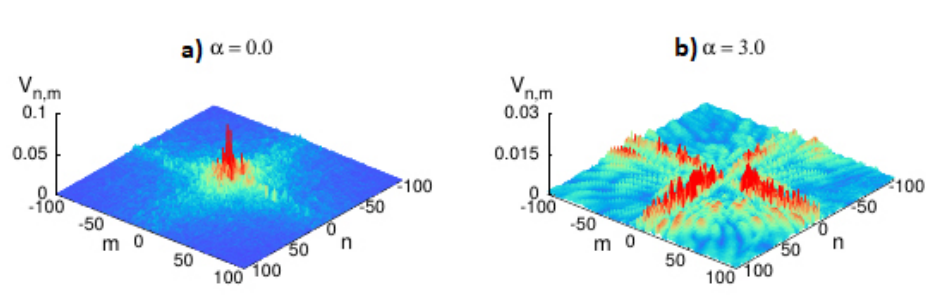
(cid:113) Figure 2 - (a, b) Velocity of mass n,m ( V n,m = (v x n,m ) 2 +(v y n,m ) 2 ) versus n and m for α = 0 and α = 3 . Calculations were done in a square lattice with N × N = 1500 × 1500 ( n = m = 0 represent the center of lattice). Classical equations were integrated until t max ≈ 600 . We observe clearly in (b) the effect of intrinsic correlations promoting a fast and intense vibrational energy